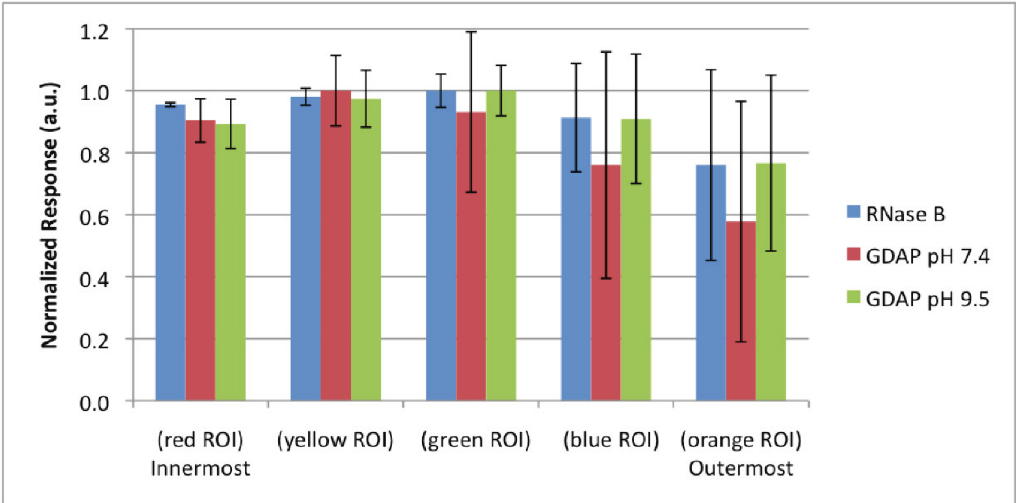
Figure 7. Normalized SPR response as a function of increasing ROI area (corresponding to SPRi images from Figure 6). SPR response was measured near maximal binding (11 min) and was highest for ROIs fully contained within the printed spots. Standard deviation of SPR response increases dramatically for ROIs that include a larger